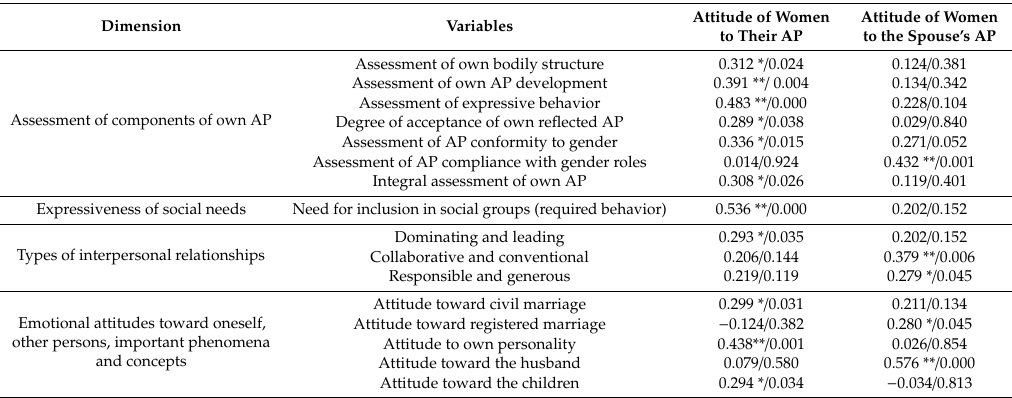
Table 1. Significant correlation relationships of attitudes to their appearance (AP) and the AP of women with their attitudes toward themselves, others, and the world.